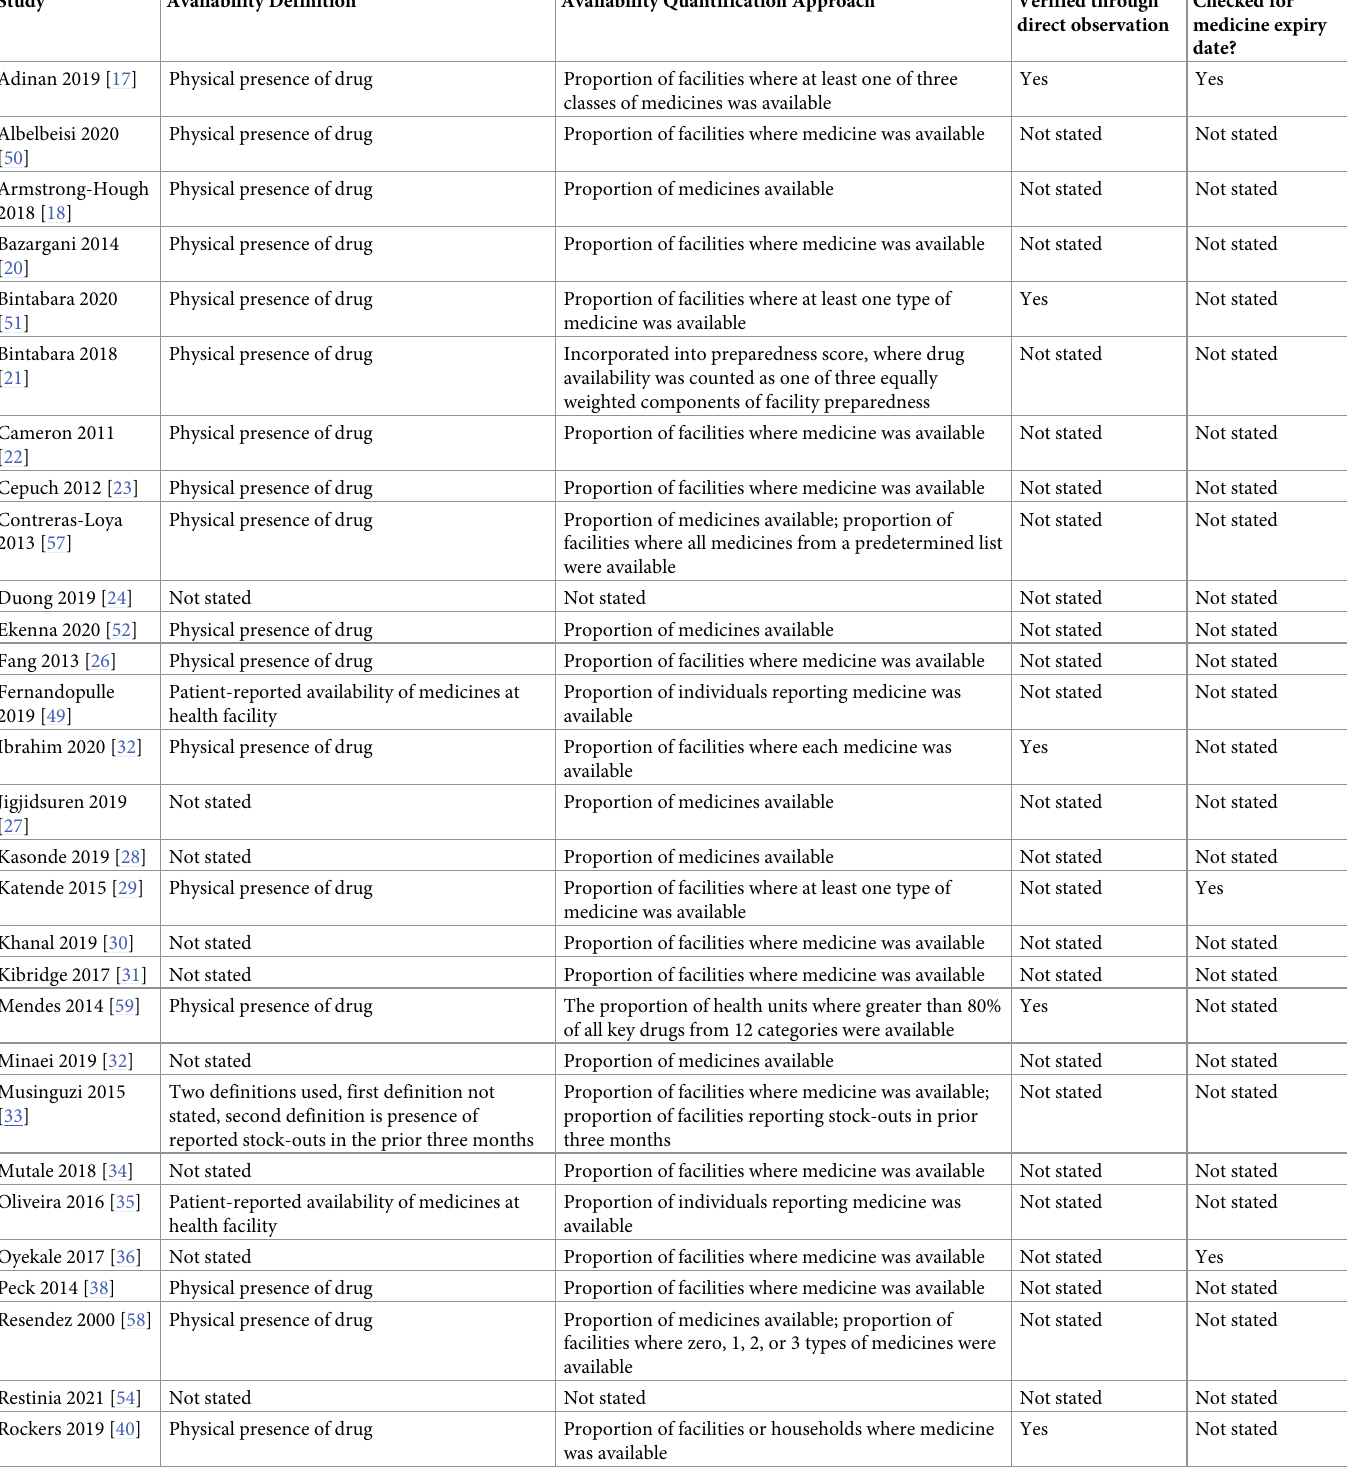
Table 3. Approaches to measuring availability by different